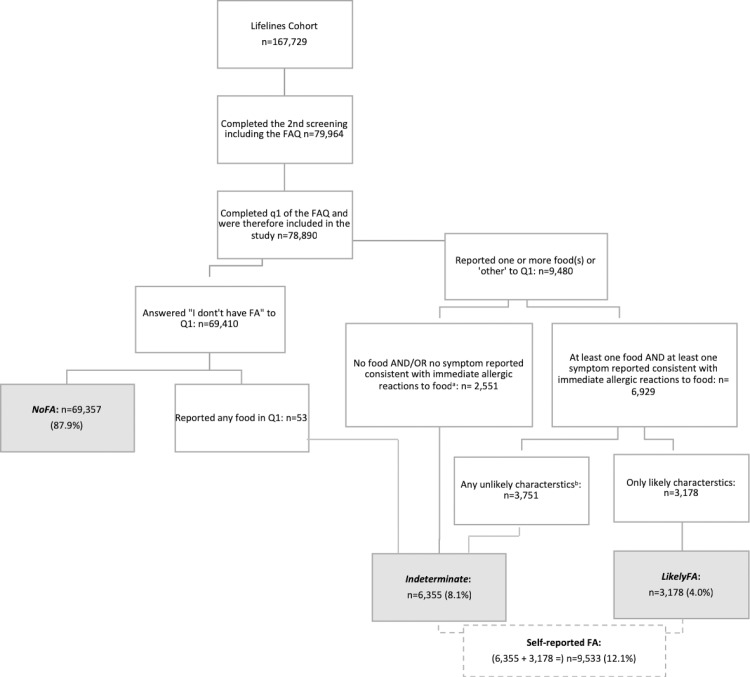
Flowchart of the study population and food allergy classification.FAQ = Food Allergy Questionnaire. Q1 = question 1 (Which of the following food-items cause an allergic reaction?). NoFA = no food allergy, LikelyFA = likely food allergy. As indicated, only subjects who reported at least one food and at least one symptom consistent with immediate allergic reactions to food and who reported only likely characteristics of food allergy were classified as LikelyFA. All other cases who reported any food in Q1 were classified as Indeterminate. a n = 372 only reported a food which caused an allergic reaction, which is not described in S1 Table since it was reported in less than 1:1000 of patients with s-rFA. Furthermore, n = 312 only reported something other than a food such as ‘I don’t know’,’ currently under investigation’ or ‘not applicable’. b These unlikely characteristics are symptoms appearing after a day or more, following at least a normal portion or more, symptoms persisting for >1 week, a diagnosis by an alternative practitioner without a diagnosis by any clinician and a negative double-blind, placebo-controlled food challenge, see Table 1.